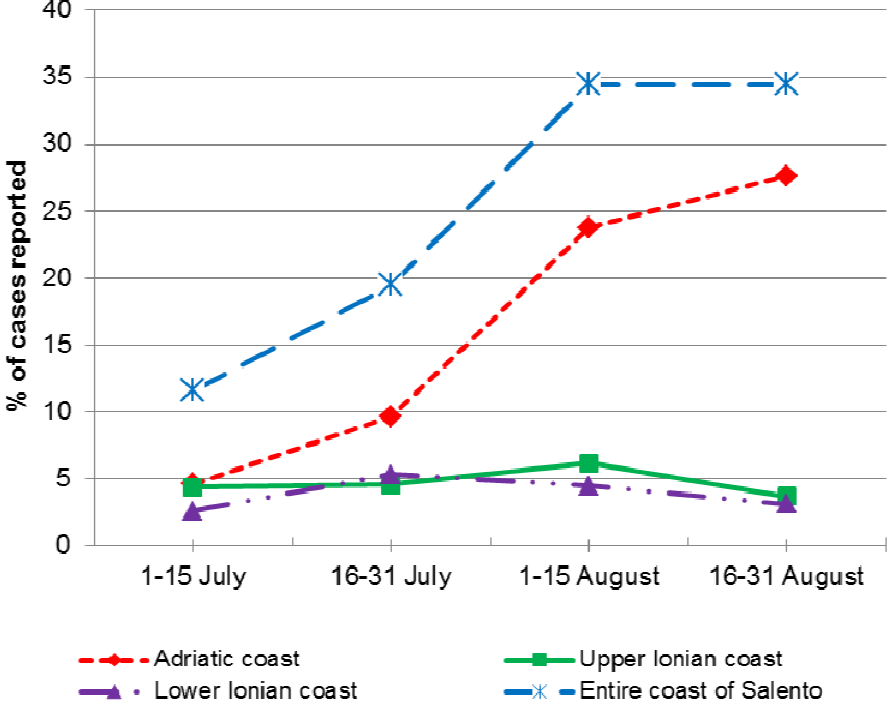
Figure 4. Spatial and temporal distribution of cases of jellyfish